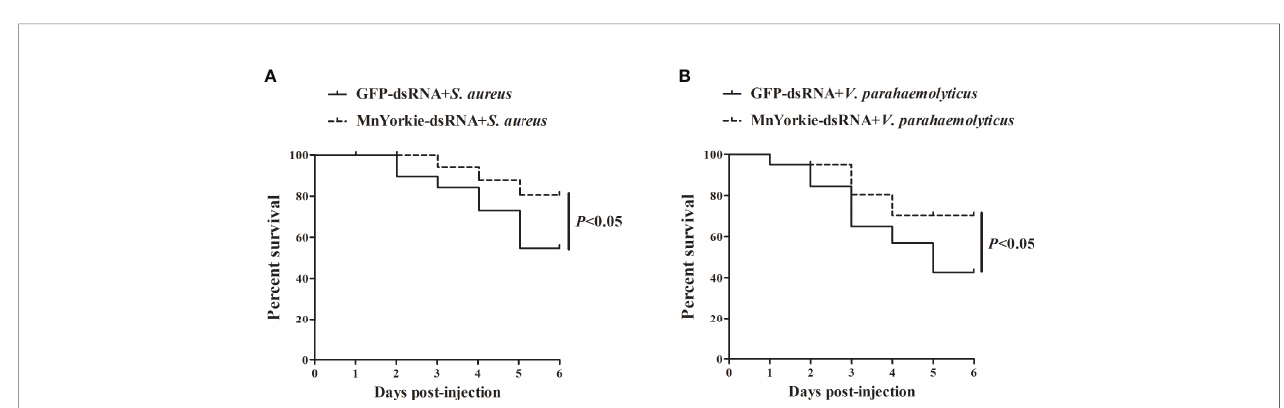
FIGURE 12 | Evaluation of M. nipponense survival rate. The prawns were co-injected with MnYorkie -dsRNA and S. aureus (A) or V. parahaemolyticus (B) . At various times (0 – 6 days) after infection, the survival rate of prawn was